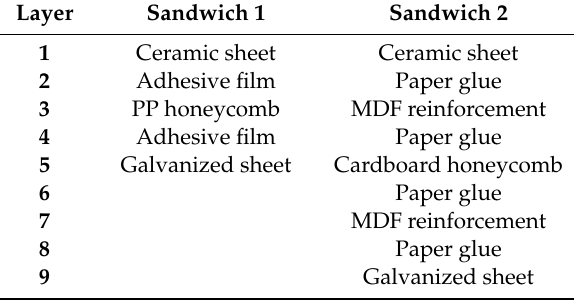
Table 1. Sequential order of the layers for the new sandwich panel solution and a typical one available on the